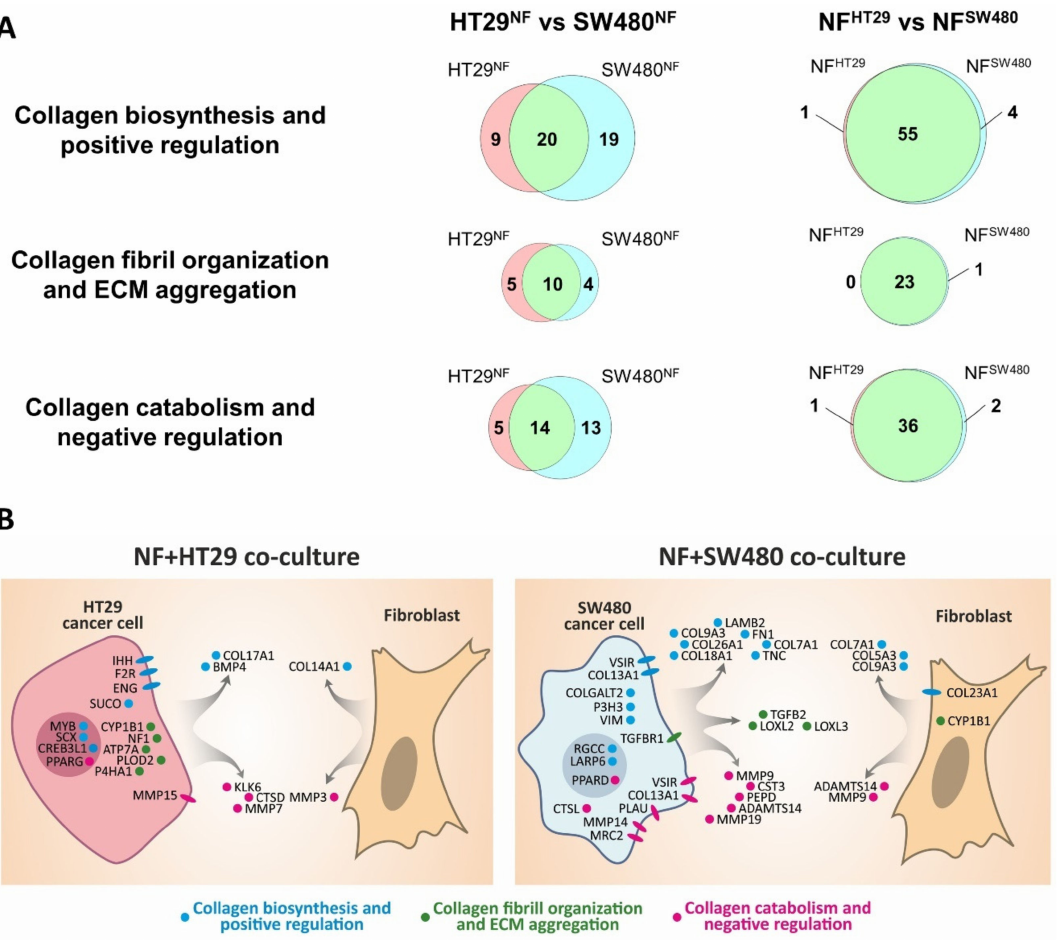
Figure 5. Di ff erential expression of the collagen-related genes in co-cultivated cancer cells and fibroblasts. ( A ) Venn diagrams showing the overlap between significantly expressed collagen-related genes ( p-adj < 0.05; TPM ≥ 5) in co-cultivated colorectal cancer cell lines (HT29 NF and SW480 NF ) and normal fibroblasts (NF HT29 and NF SW480 ). Three gene categories are shown: collagen biosynthesis and positive regulation, collagen fibril organization and ECM aggregation, and collagen catabolism and negative regulation. ( B ) Scheme showing localization of collagen-related proteins that can determine di ff erences in collagen remodeling by di ff erent co-cultures. Collagen-related di ff erentially expressed genes ( p-adj < 0.05; TPM ≥ 5; | log2(FC) | ≥ 1)) were determined between cancer cells and between fibroblasts of both co-cultures. Some SW480 DEGs encoding extracellular proteins were excluded because of their much higher expression in fibroblasts (log2(FC) ≥